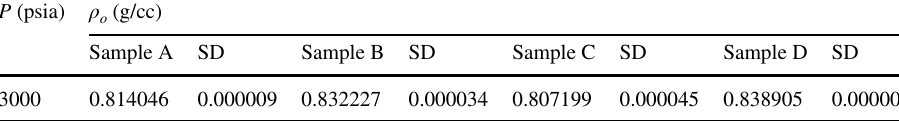
Table 5 Density of four oil samples at 25 °C and 3000 psia